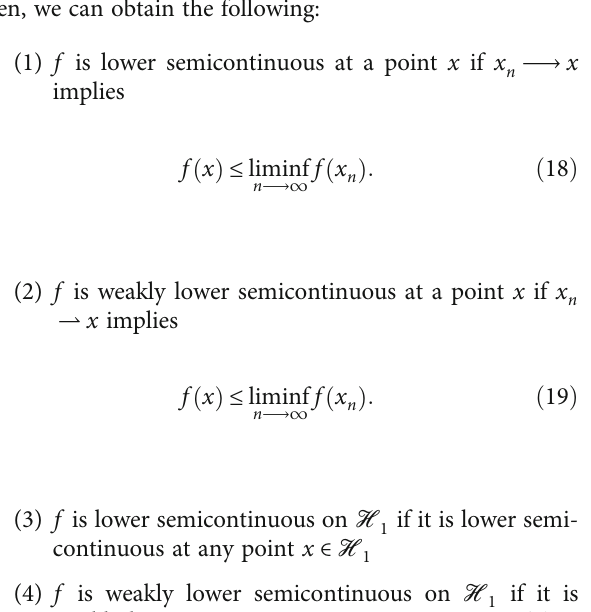
Algorithm 1. Let x be arbitrary, and generate f x n g accord- 0 ing to the following iterative